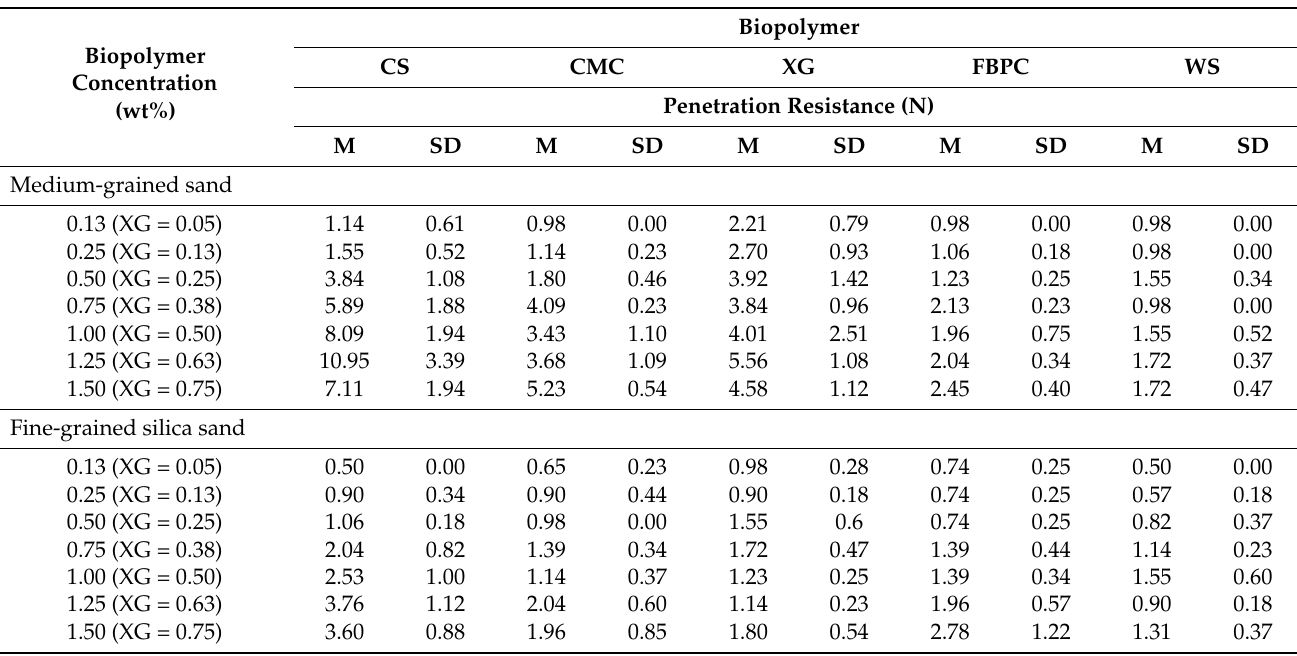
Table A4. Results of Phase 1 penetrometer tests. Penetration resistance of medium-grained sand and fine-grained silica sand samples treated at different biopolymer concentrations. Tests were performed on day 28 after initial treatment (after the fifth and last wind tunnel cycles). Each of the three prepared samples was penetrated at the top and bottom of the centre (n =